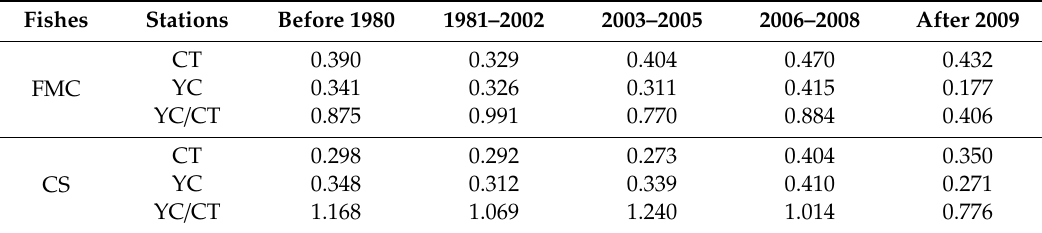
Table 2. Satisfying degree of SF for the FMC and the CS during di ff erent stages.